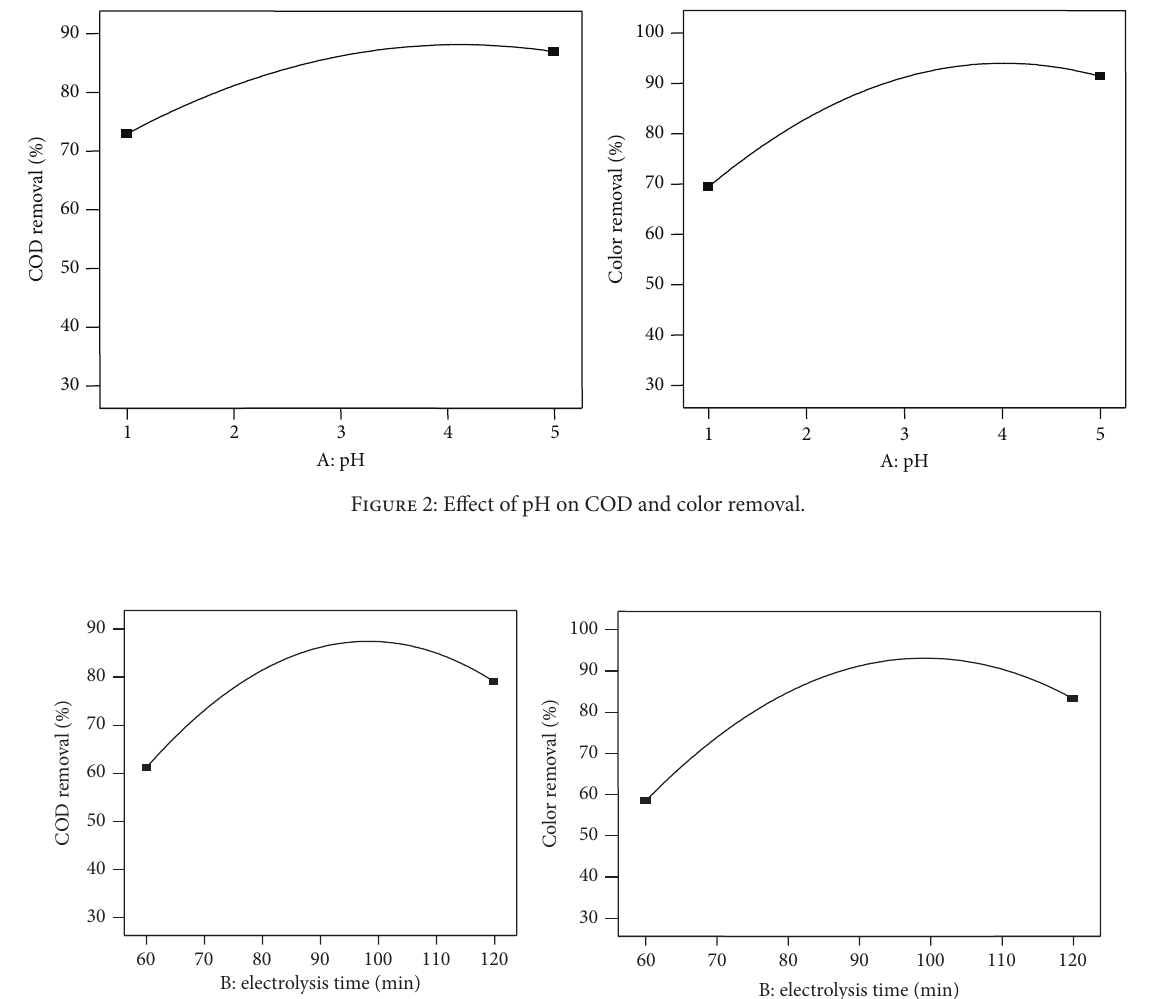
Figure 3: Effect of electrolysis time on COD and color removal.